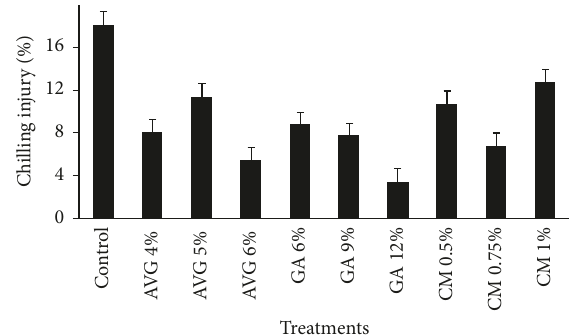
Figure 5: Effect of Aloe vera gel, gum arabic, and cinnamon oil coatings on chilling injury percentage of bell pepper during cold storage. AVG: Aloe vera gel; GA: gum arabic; CM: cinnamon oil.